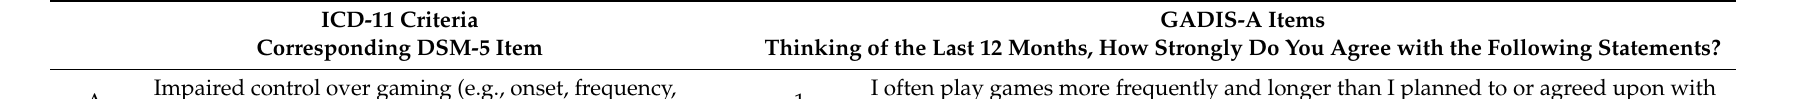
Table 1. GADIS-A items with corresponding ICD-11 and DSM-5